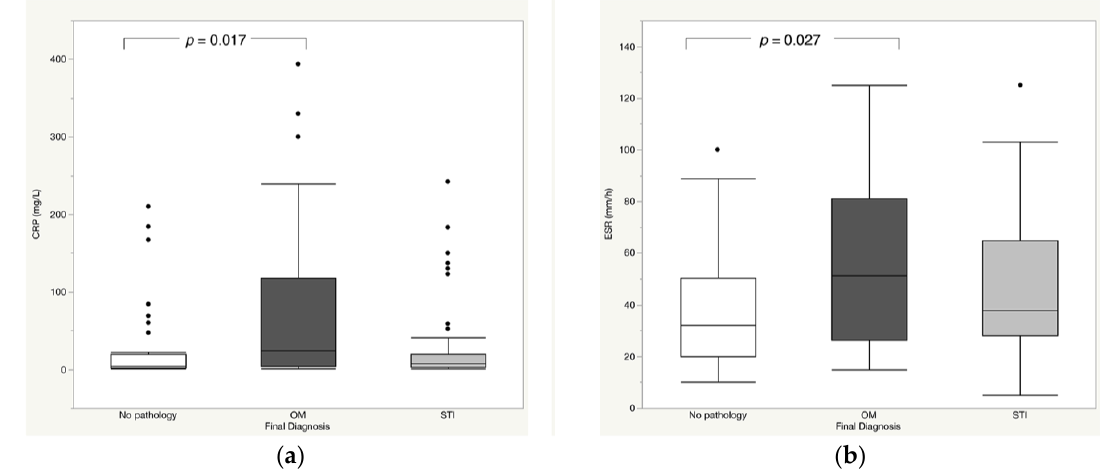
Figure 1. Box plots of C-reactive protein (CRP) ( a ) and erythrocyte sedimentation rate (ESR) ( b ) showing significantly higher values of CRP (median value 24.0 mg/L; min to max: 1 – 393.80) and ESR (median value 51.5 mm/h; min to max: 15.0 – 125) compared with non-infected patients (median values of CRP: 4.5 mg/L; min to max: 1 – 210); median values of ESR: 32.0; min to max: 10 – 100). OM: osteomyelitis; STI: soft tissue infection. Table 2. Microbiology and histopathological findings.